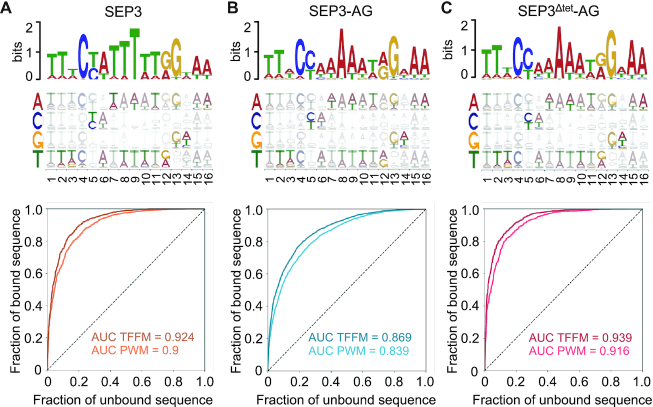
Modeling of TF binding sites. (A) (Top) PWM logo for SEP3 based on the top 600 bound regions. PWM computed using the MEME suite. (Middle) TFFM with dinucleotide dependencies depicted schematically. Darker colors indicate stronger dependency on the identity of the previous nucleotide. Nucleotides are color coded and shown on the y-axis and position given on the x-axis. (Bottom) PWM and TFFM were used to determine the ROC curves and AUC values. PWM are colored in light orange and TFFM in dark orange. A perfect model would account for 100% of bound regions with no false positives and yield an AUC of 1. The AUC indicate a strongly predictive model with the TFFM performing better as shown by the higher AUC scores. (B) (Top) PWM logo for SEP3–AG calculated as per (A). (Middle) TFFM for SEP3–AG. (Bottom) ROC curves and AUC values with PWM in light blue and TFFM in dark blue. (C) (Top) PWM logo for SEP3Δtet-AG calculated as per (A). (Middle) TFFM for SEP3–AG. (Bottom) ROC curves and AUC values with PWM in pink and TFFM in dark pink.